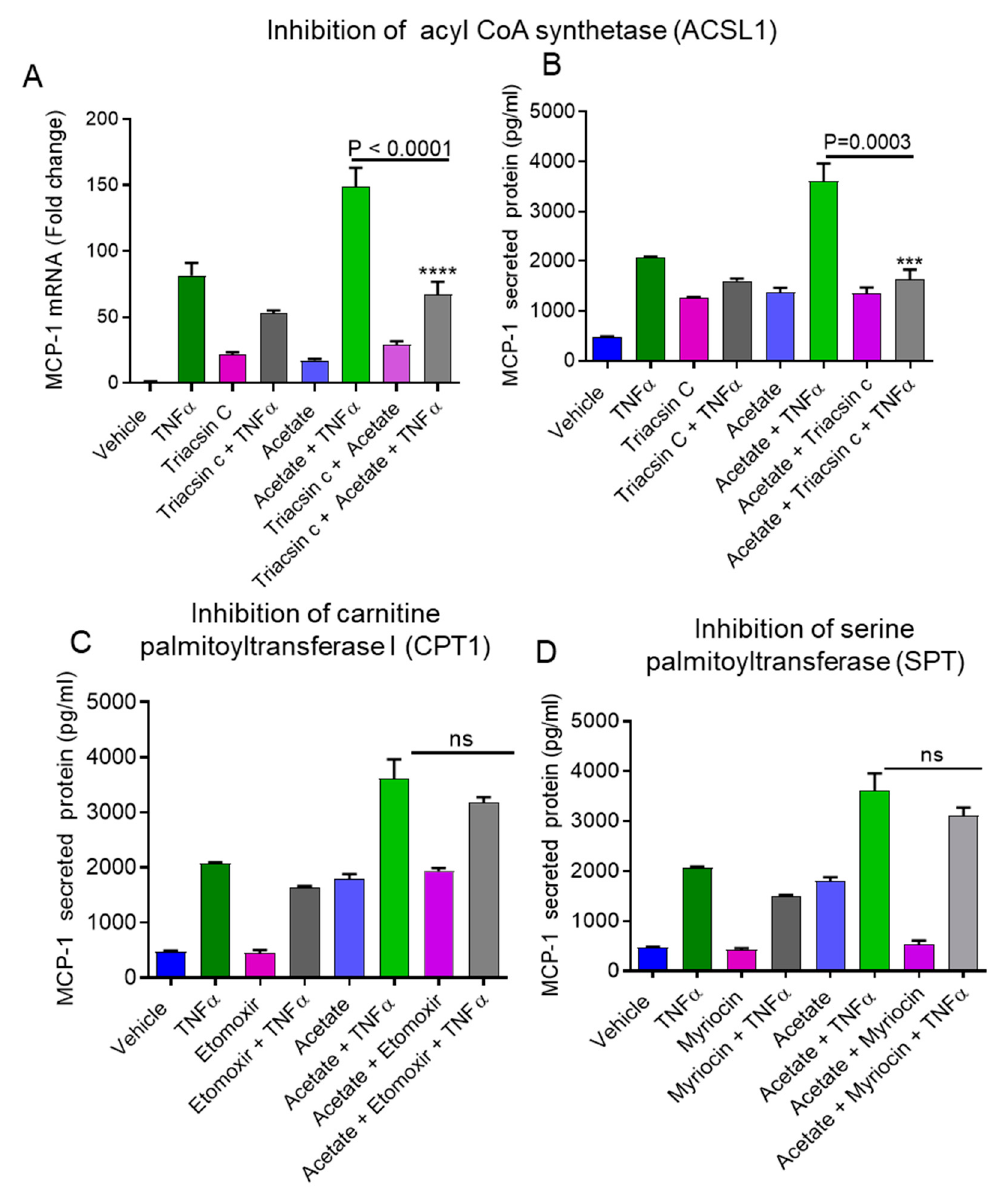
Figure 4. ACSL1 inhibition reduces acetate/TNF α mediated synergistic MCP-1 production in monocytes. Monocytic cells were pretreated with inhibitors (Triacsin c:(4 uM), etomoxir (10 uM), myriocin (50 nM)) or vehicle for 1 h and then incubated with acetate/TNF α for 24 h. ( A ) MCP-1 mRNA was determined by real-time PCR and ( B – D ) MCP-1 protein was determined by ELISA. The results obtained from three independent experiments are shown. All data are expressed as mean ± SEM (n = 3). *** p < 0.001, **** p < 0.0001 versus TNF α alone. ns indicates